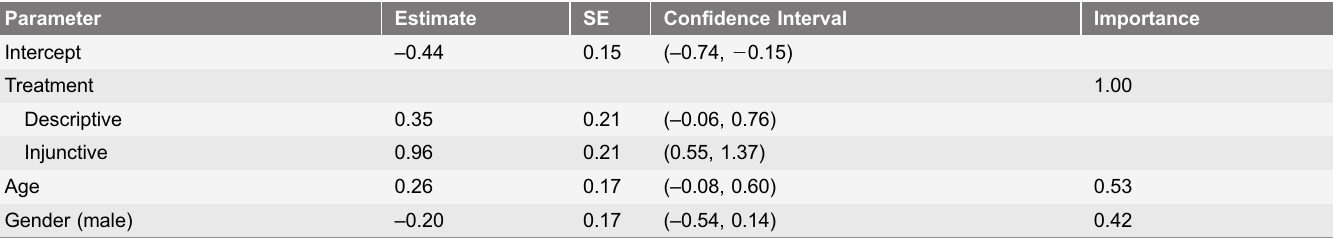
Table 3. Estimates, standard errors and confidence intervals for parameters included in the top models investigating factors affecting compliance with the ‘give $0.50’